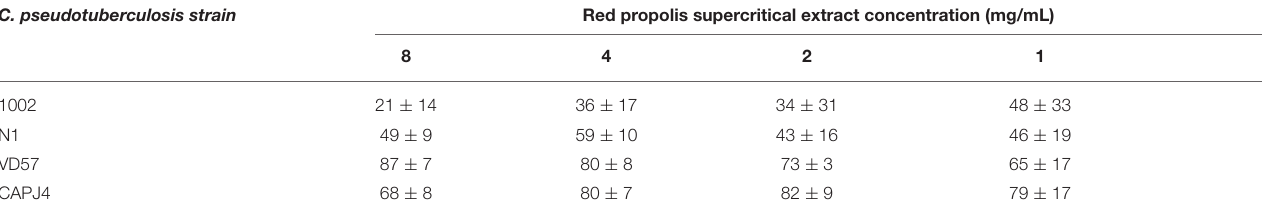
TABLE 6 | Interference by the supercritical extract of red propolis in the formation of C. pseudotuberculosis